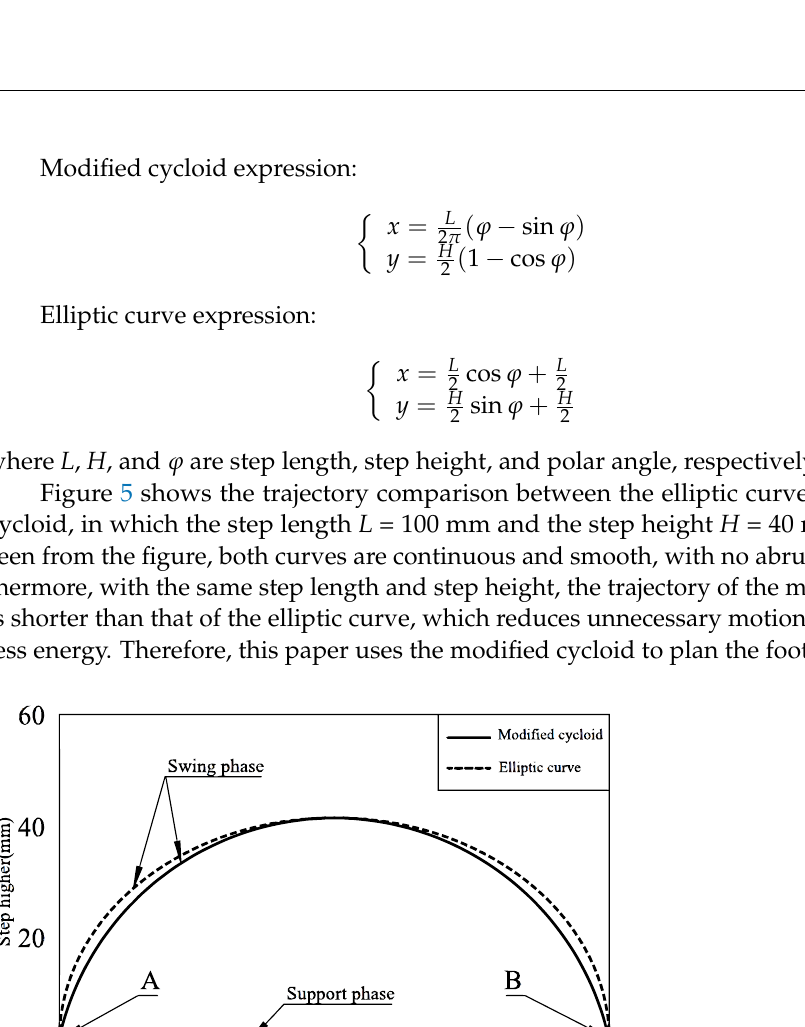
Figure 6. Optimized foot trajectory.